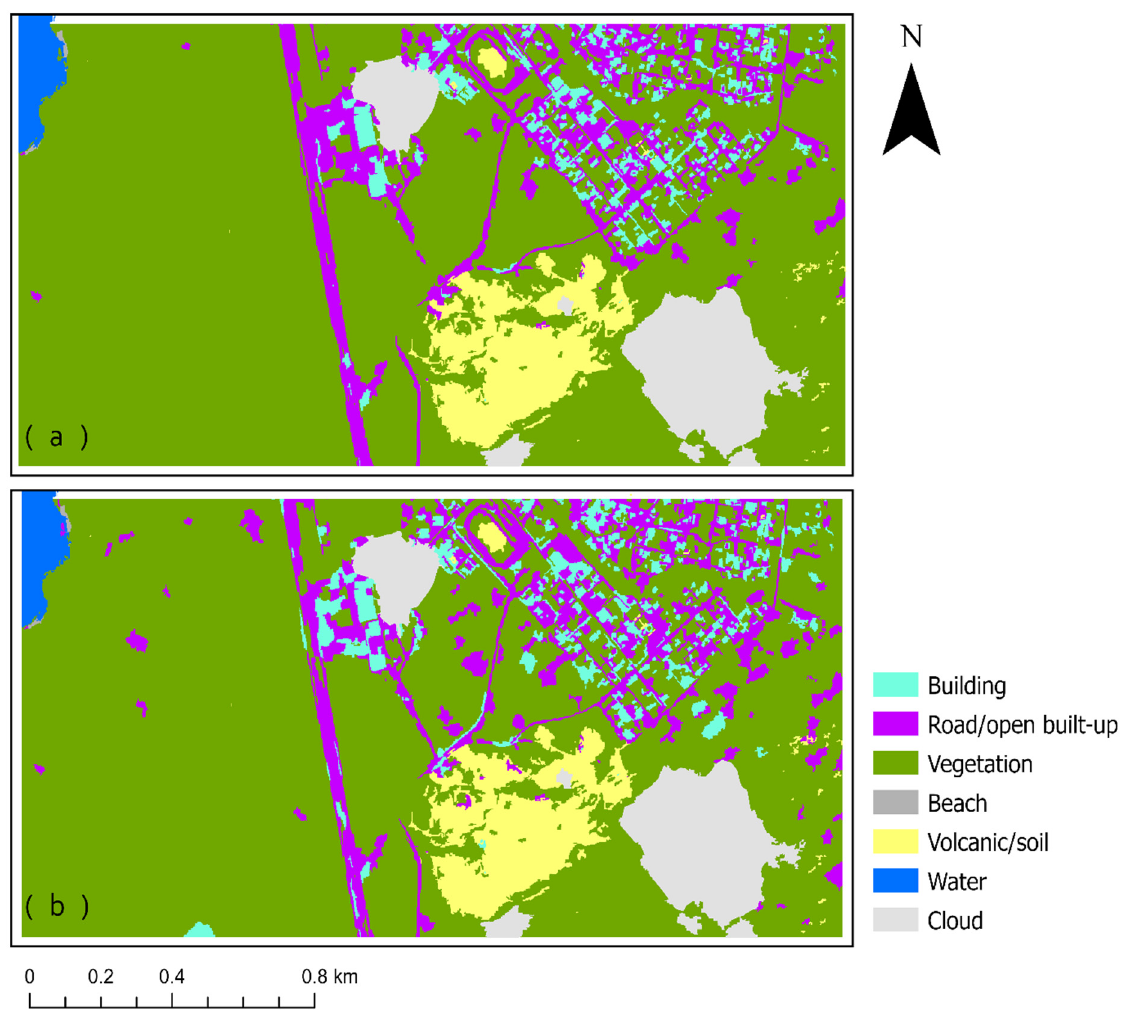
Figure 7. VGG16 classification results: ( a ) with Gaussian assistance and ( b ) without Gaussian assistance. Only testing image (southern portion of the study area) is presented to evaluate generalization capability. Table 4. Error matrix for VGG16 mapping (with Gaussian assistance) was generated using refer- ence data derived from the visual interpretation of a WorldView-2 image and the Google Earth’s very high-resolution imagery archive. A total of 150 image objects were randomly selected for the accuracy assessment. UA and PA denote user’s and producer’s accuracy, respectively.